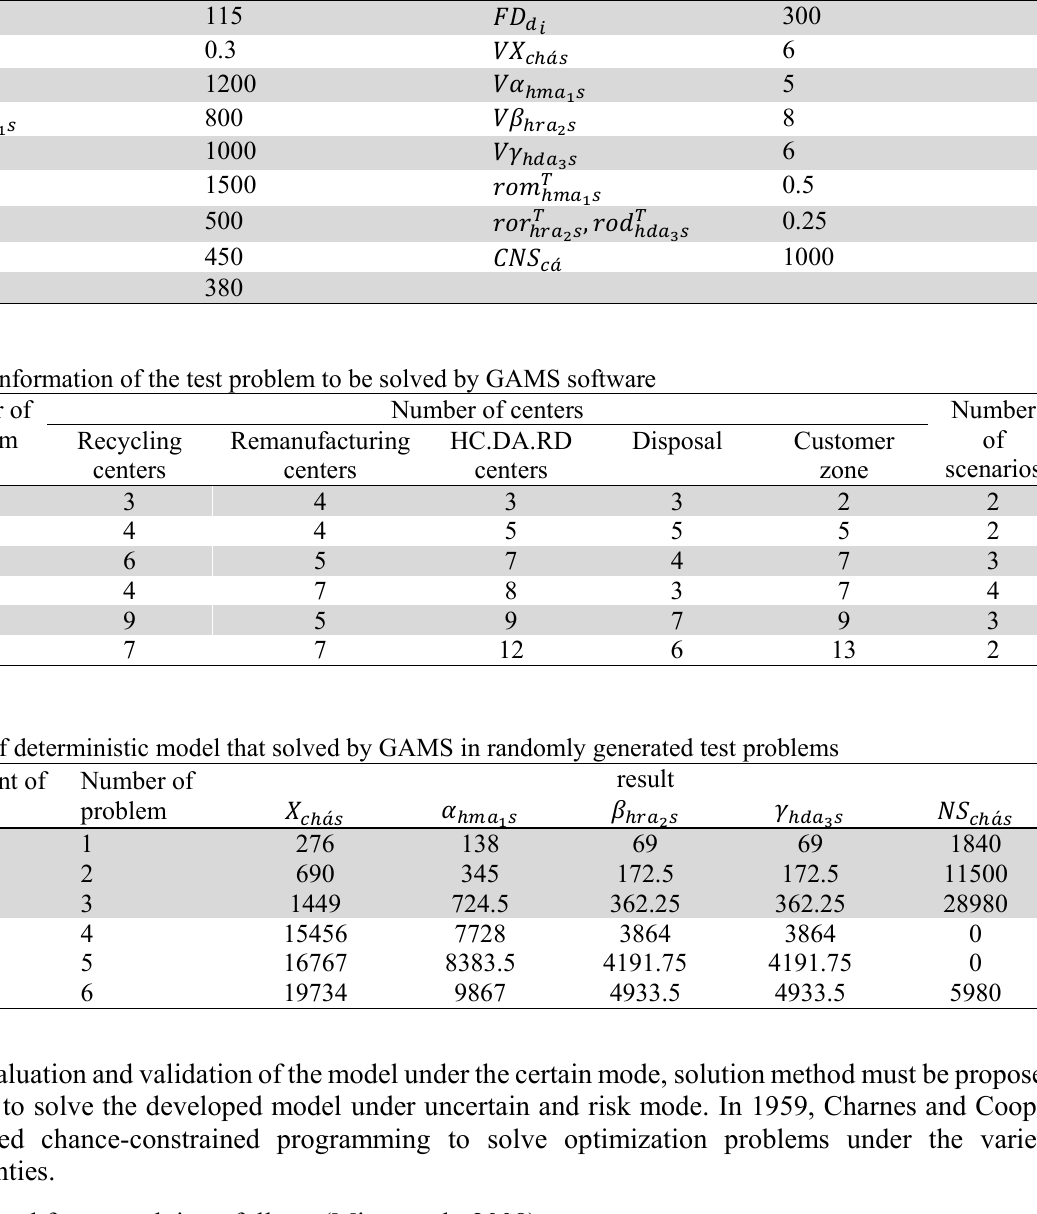
Input data of GAMS software parameters The amount attributed Parameters The amount attributed